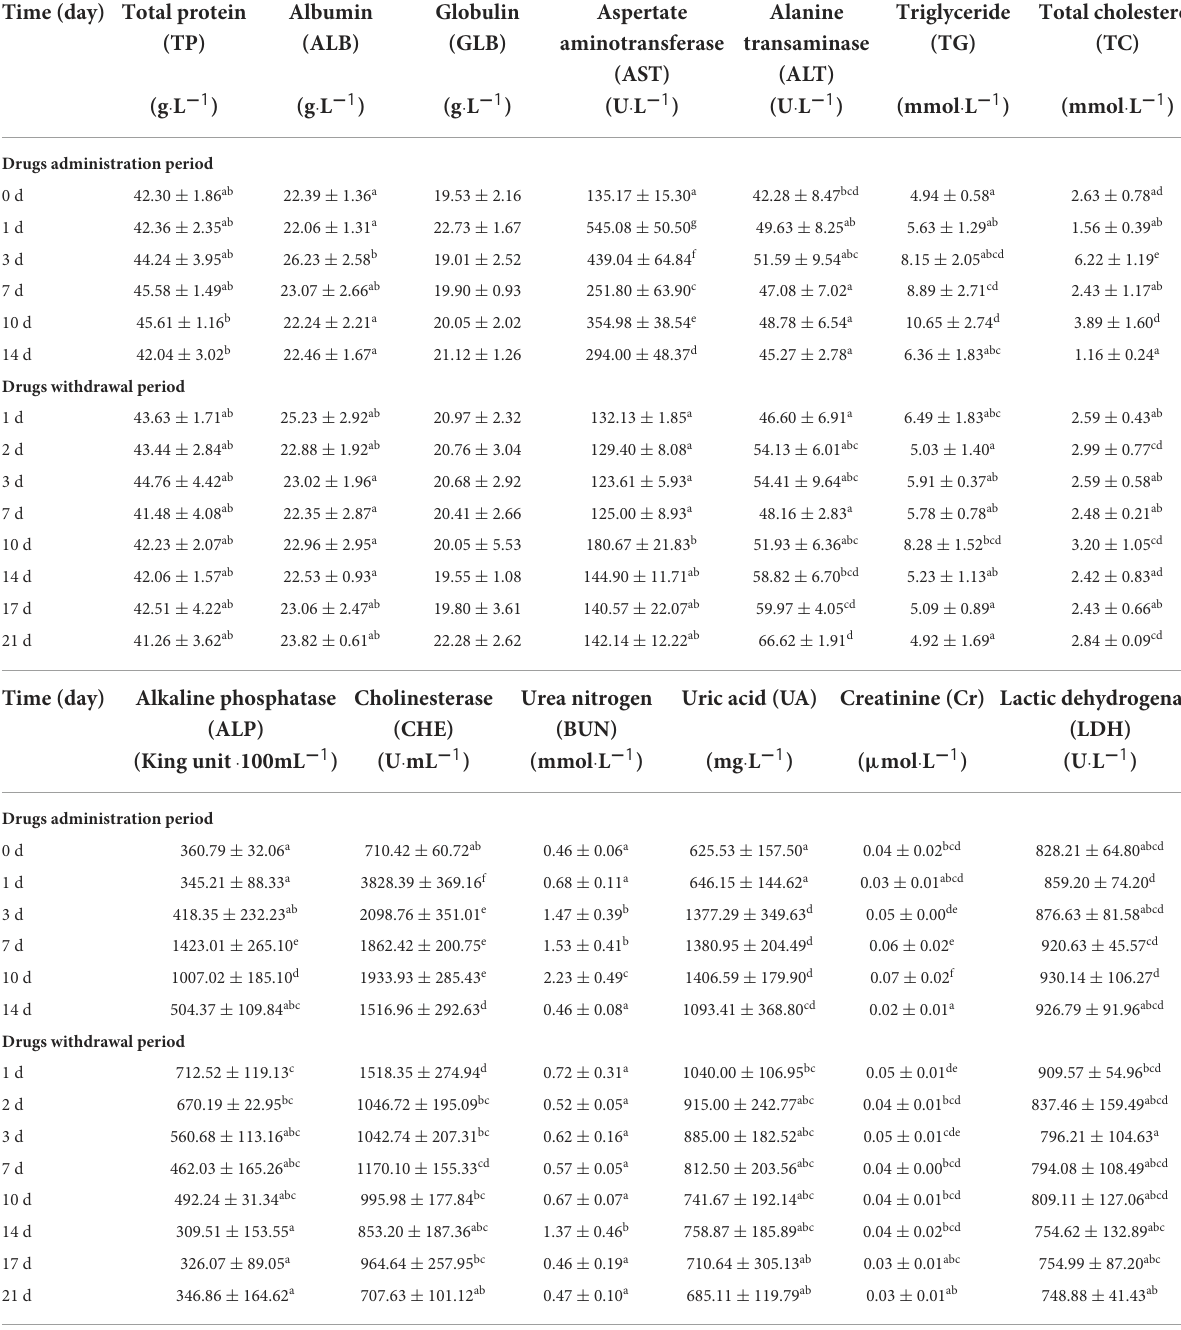
TABLE 2 Effects of deltamethrin on blood biochemical indexes of laying